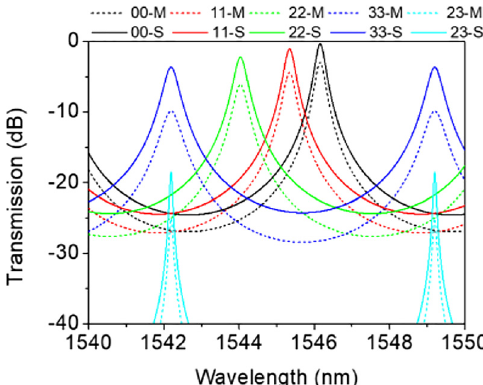
Figure 4: Simulated transmission spectra of the MMRR for TE 0 – TE 3 modeinputwithinoneFSRwith(dashlines)andwithout(solidlines) considering the fabrication loss.